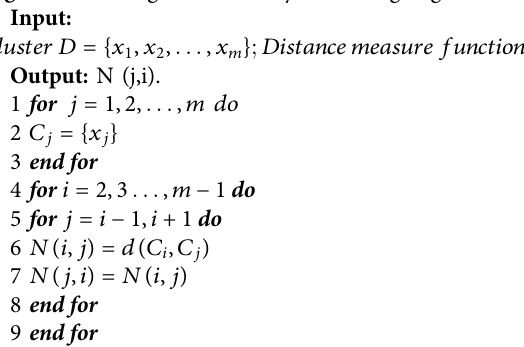
Algorithm 1. Angular Similarity Clustering Algorithm.